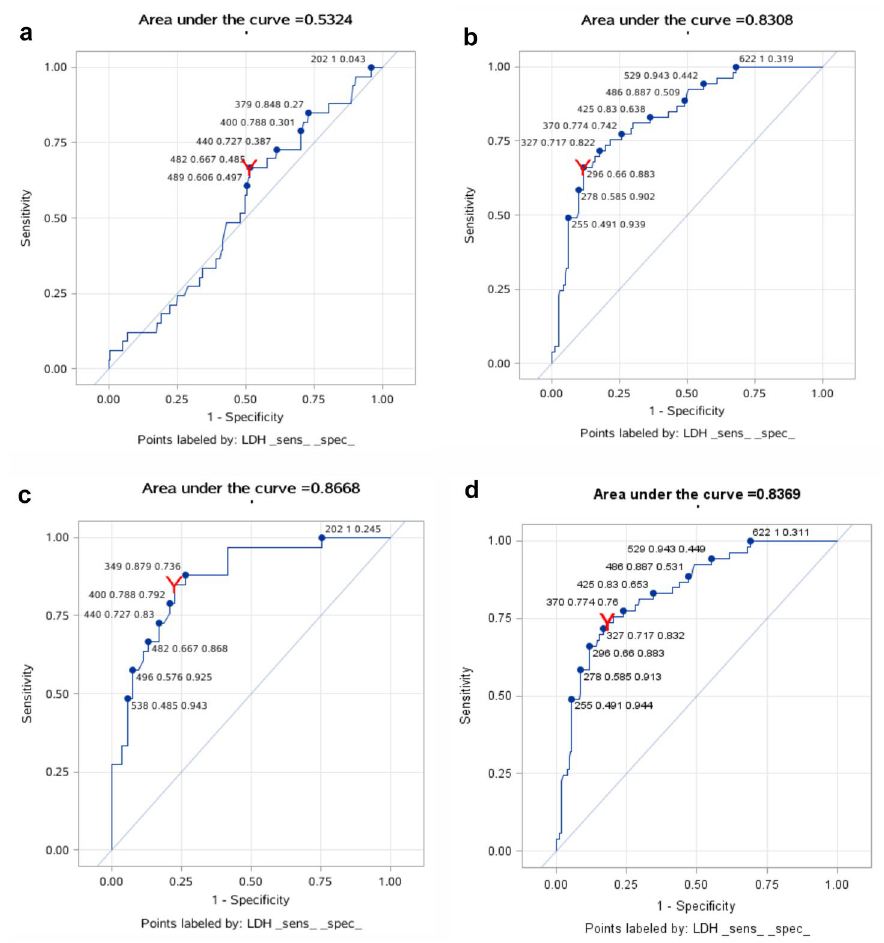
Figure 5. ( a ) The ROC curves for LDH of probable PCP and proven PCP groups; ( b ) The ROC curves for LDH of probable PCP and NO PCP groups; ( c ) The ROC curves for LDH of proven PCP and NO PCP groups; ( d ) The ROC curves for LDH of proven/probable PCP and NO PCP